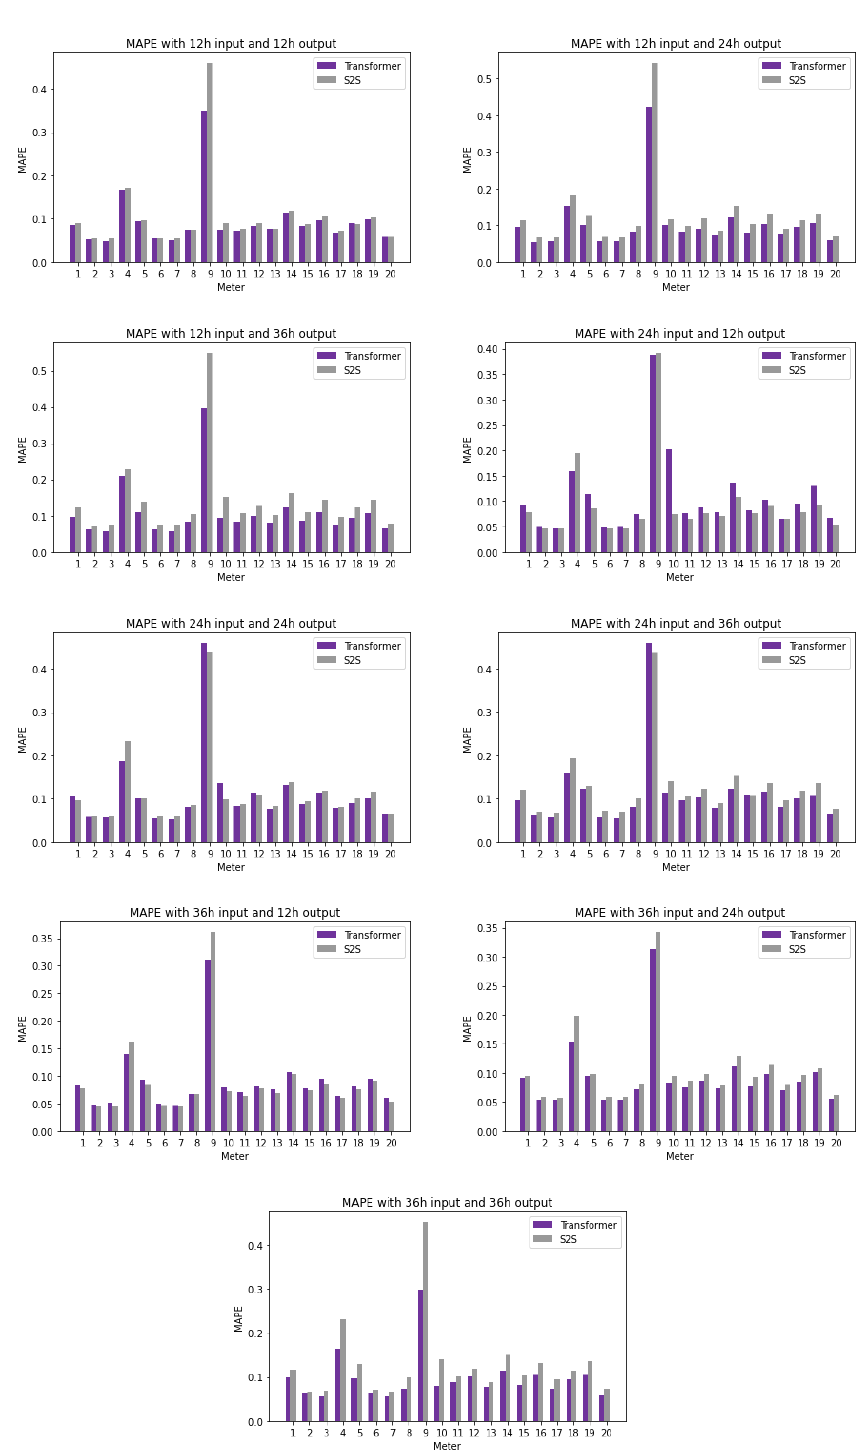
Figure 9. MAPE comparison for each stream under each forecasting horizon and input window size between the transformer model and S2S